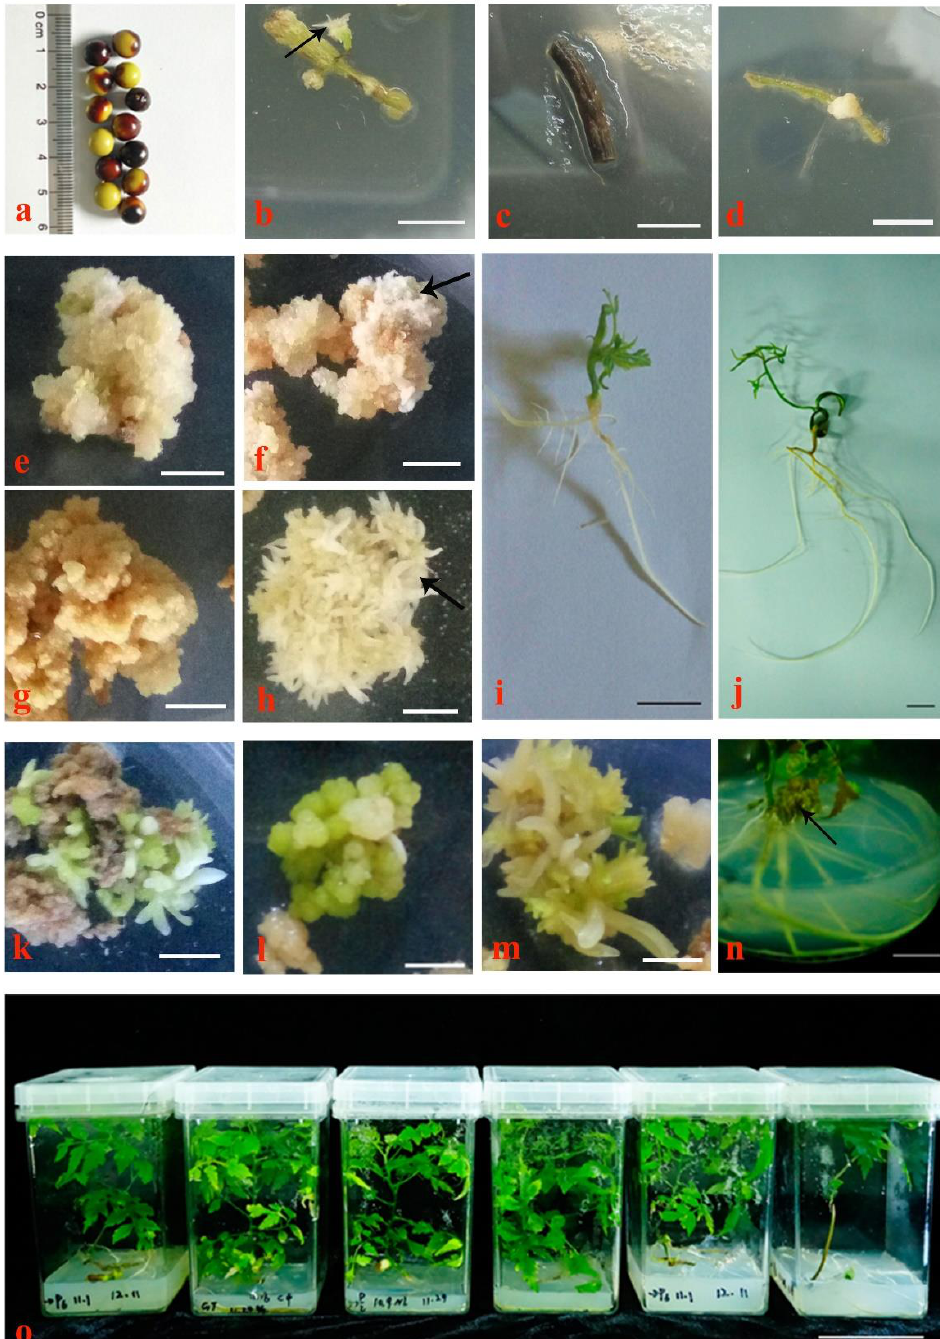
Figure 1. Koelreuteria paniculata Laxm. plant regeneration from in vitro culture of zygotes and from somatic embryogenesis (SE). ( a ) Immature seeds. ( b ) Aerial roots (arrow in b ) incubated on I1 medium. ( c ) Browning stem segment incubated on I3 medium. ( d ) Calluses incubated on I6 medium. ( e ) Embryogenic calluses incubated on DKW (Driver-Kuniyuki Walnut) medium. ( f ) Aerial roots (arrow in f ) on IEM3 (IEM, Induction Medium of Embryogenic Calluses). ( g ) Callus cultured for more than three months. (h ). ( k ) Globular and cotyledon embryos, respectively, under light. ( i ) Plantlet derived via SE. ( j ) Plantlet derived via zygotic embryo. ( l ) White, translucent embryogenic calluses (arrow in l ) and cotyledon embryos cultured in darkness. ( m ) Brown, hard embryogenic calluses cultured in light. ( n ) Calluses (arrow in n ) produced in clonal culture of stem sections. ( o ) Plantlets from zygotic embryos. Scale bar: a – r = 1 cm, s = 10 cm.